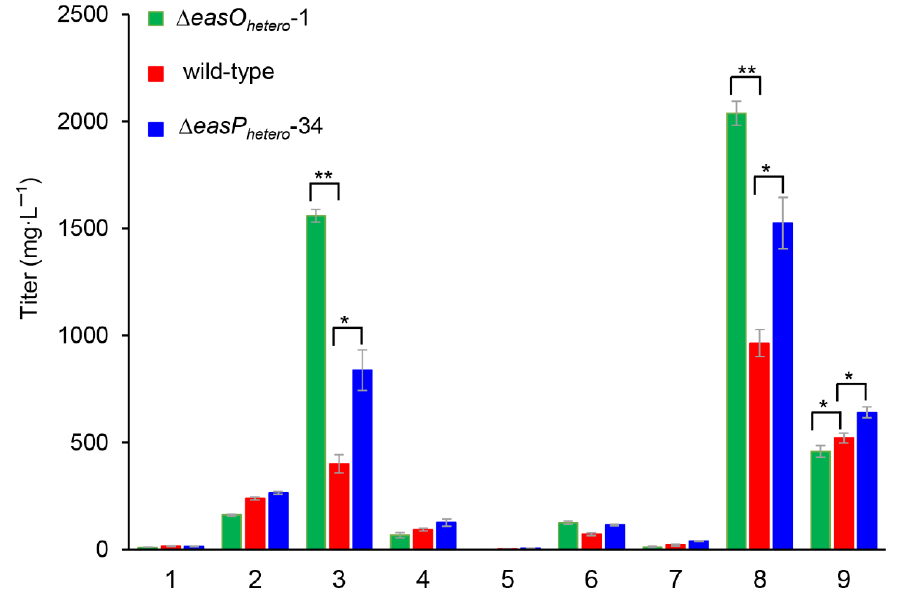
Figure 5. The quantitative analysis of ergot alkaloids production (mg ∙ L − 1 ) from different strains